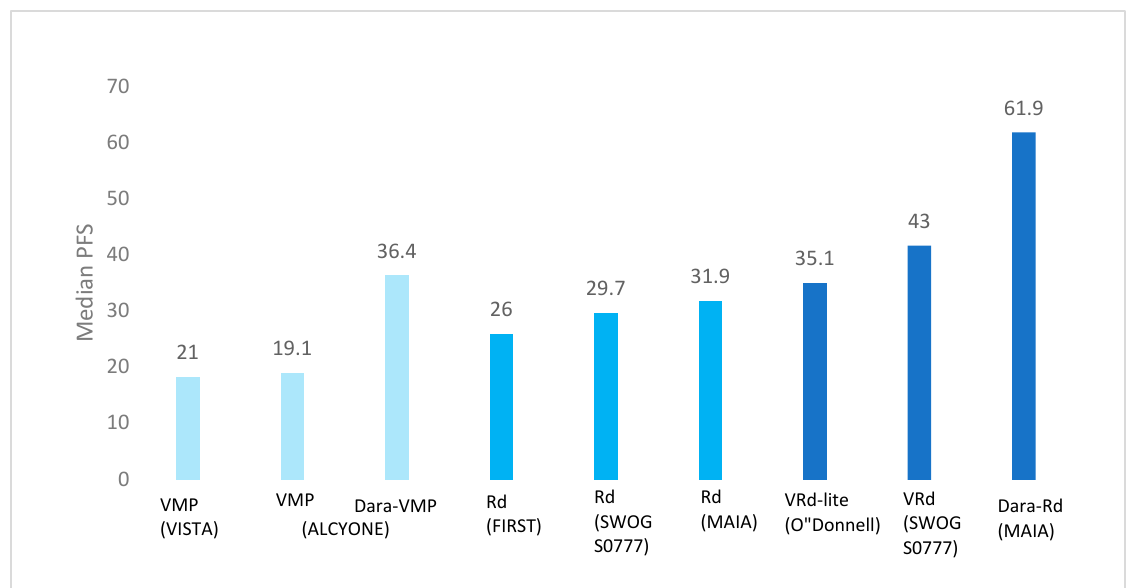
Figure 1. Overview of median PFS in NTE NDMM phase 3 clinical trials.